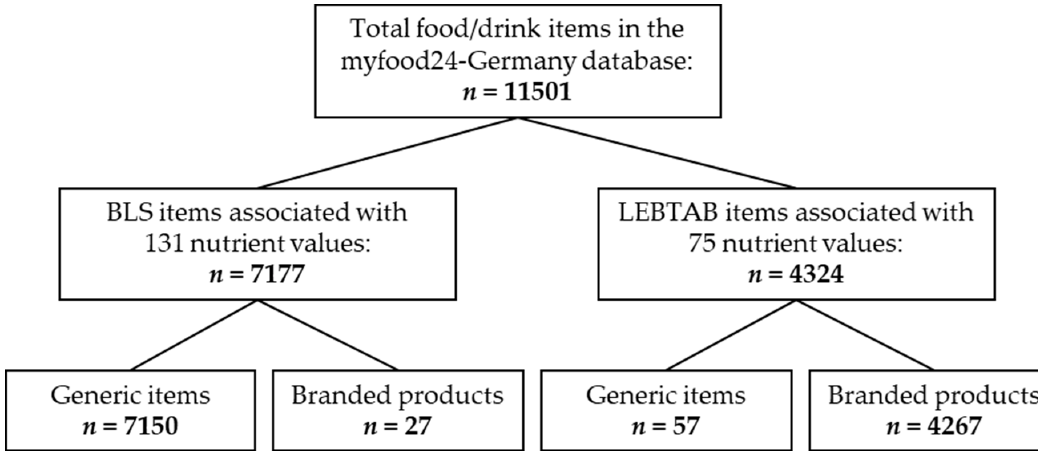
Figure 2. Flow chart of the myfood24-Germany database entries.